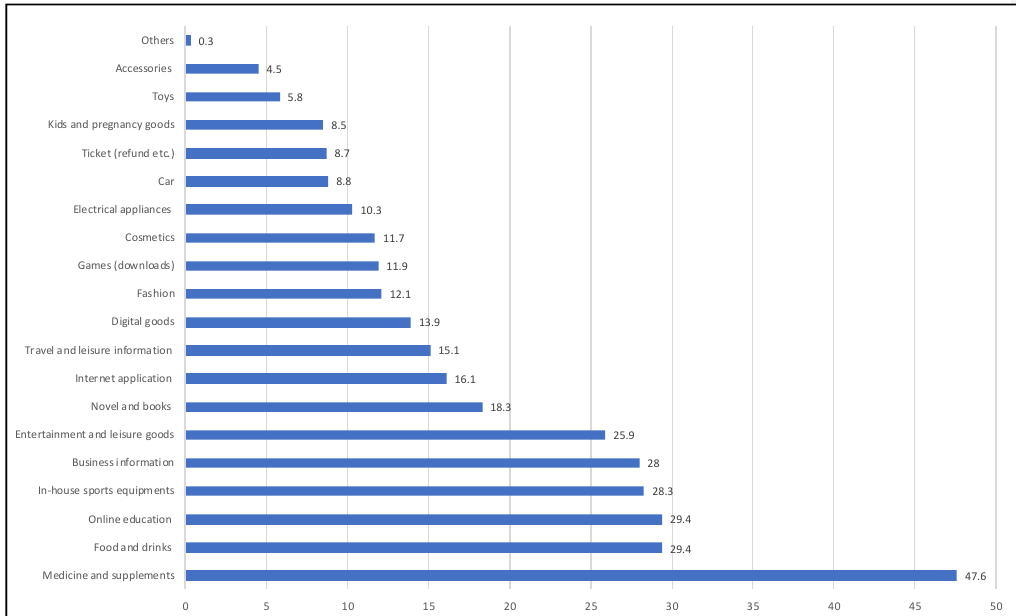
Figure 5. Types of information needed by people through online platforms; (Source: this figure was prepared by the authors using original data from: CSM Media Research [23]).